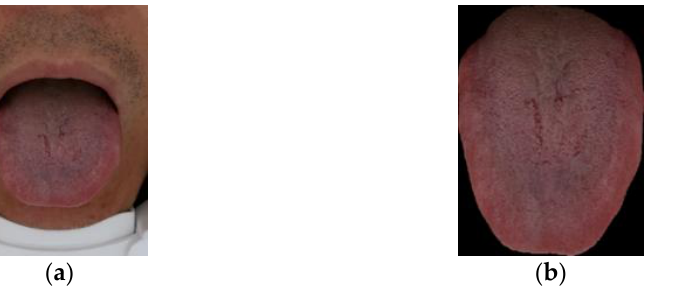
Figure 1. The acquired original image and the corresponding segmented image. ( a ) Raw image; ( b ) Image after segmentation.